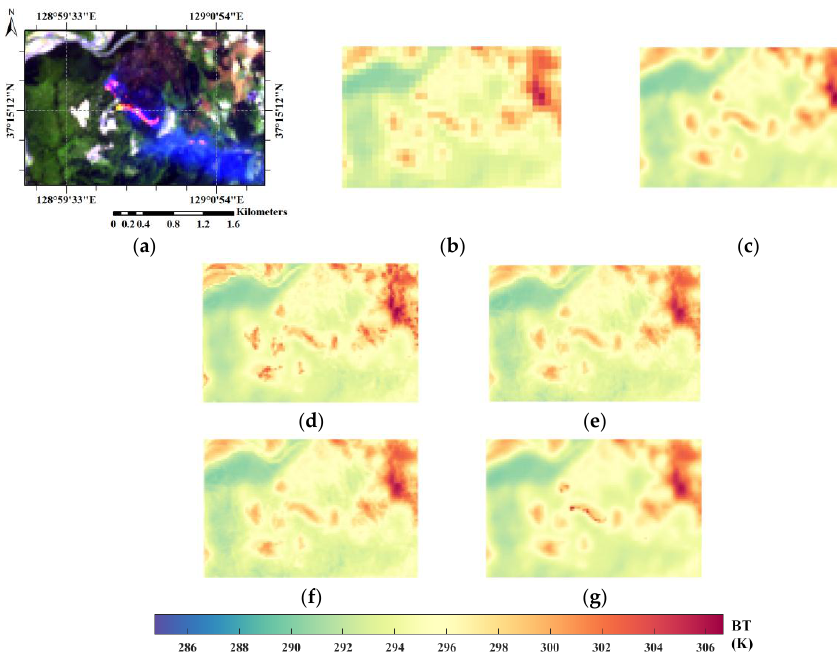
Figure 6. Disaggregated brightness temperature results at subset A: ( a ) SWIR2-SWIR1-Blue composite image; ( b ) Original BT image; ( c ) Distributed BT image; ( d ) DisTrad method; ( e ) TsHARP method; ( f ) LMS method; ( g ) Proposed GF method.